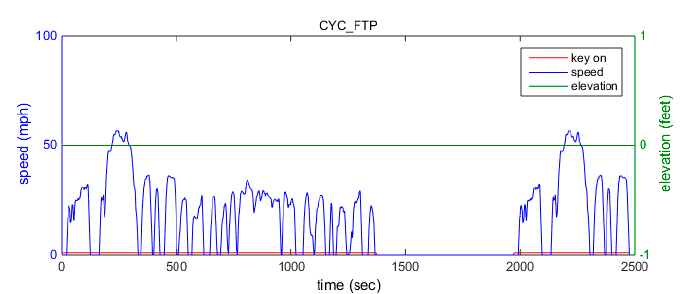
Figure 2. Federal Test Procedure (FTP) driving cycle.